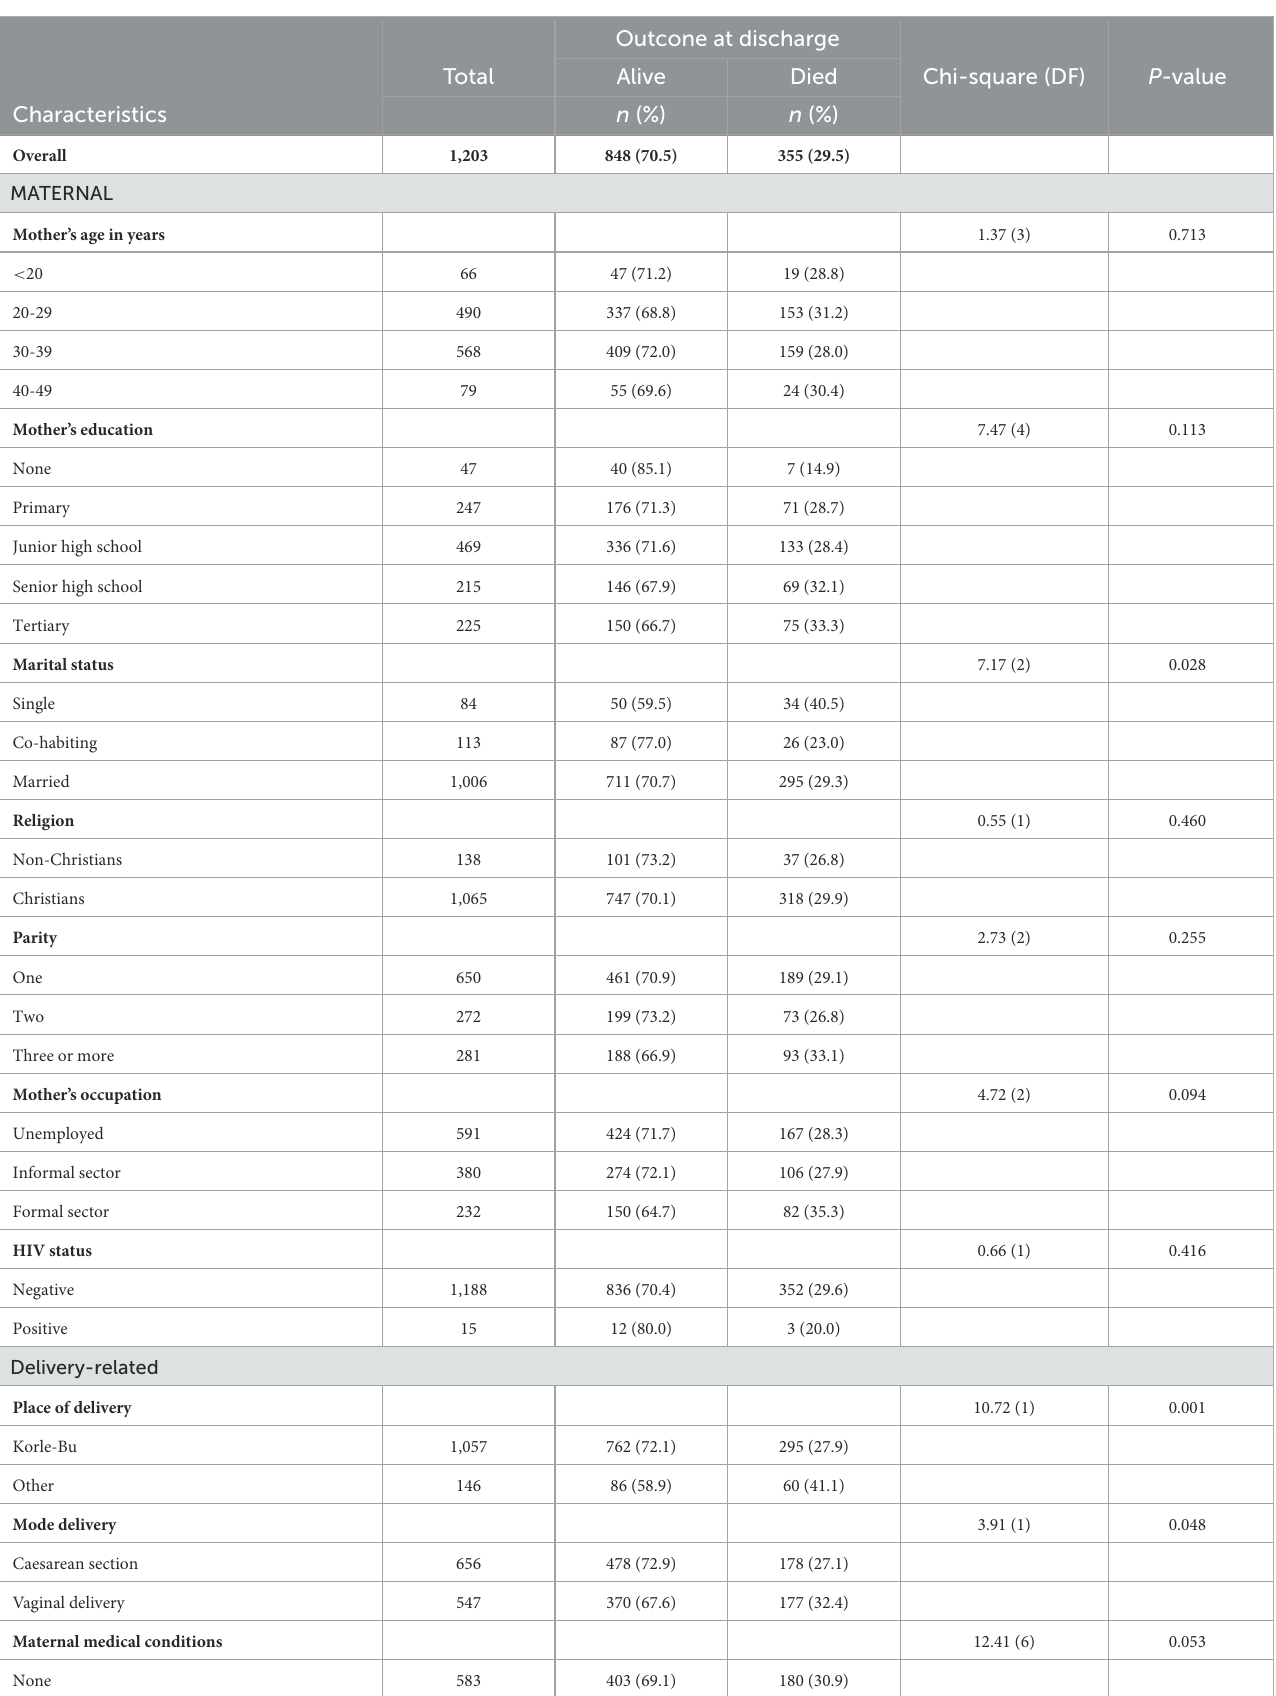
TABLE 2 Prevalence and association between death before discharge and demographic characteristics among preterm newborns admitted at the NICU. Outcone at